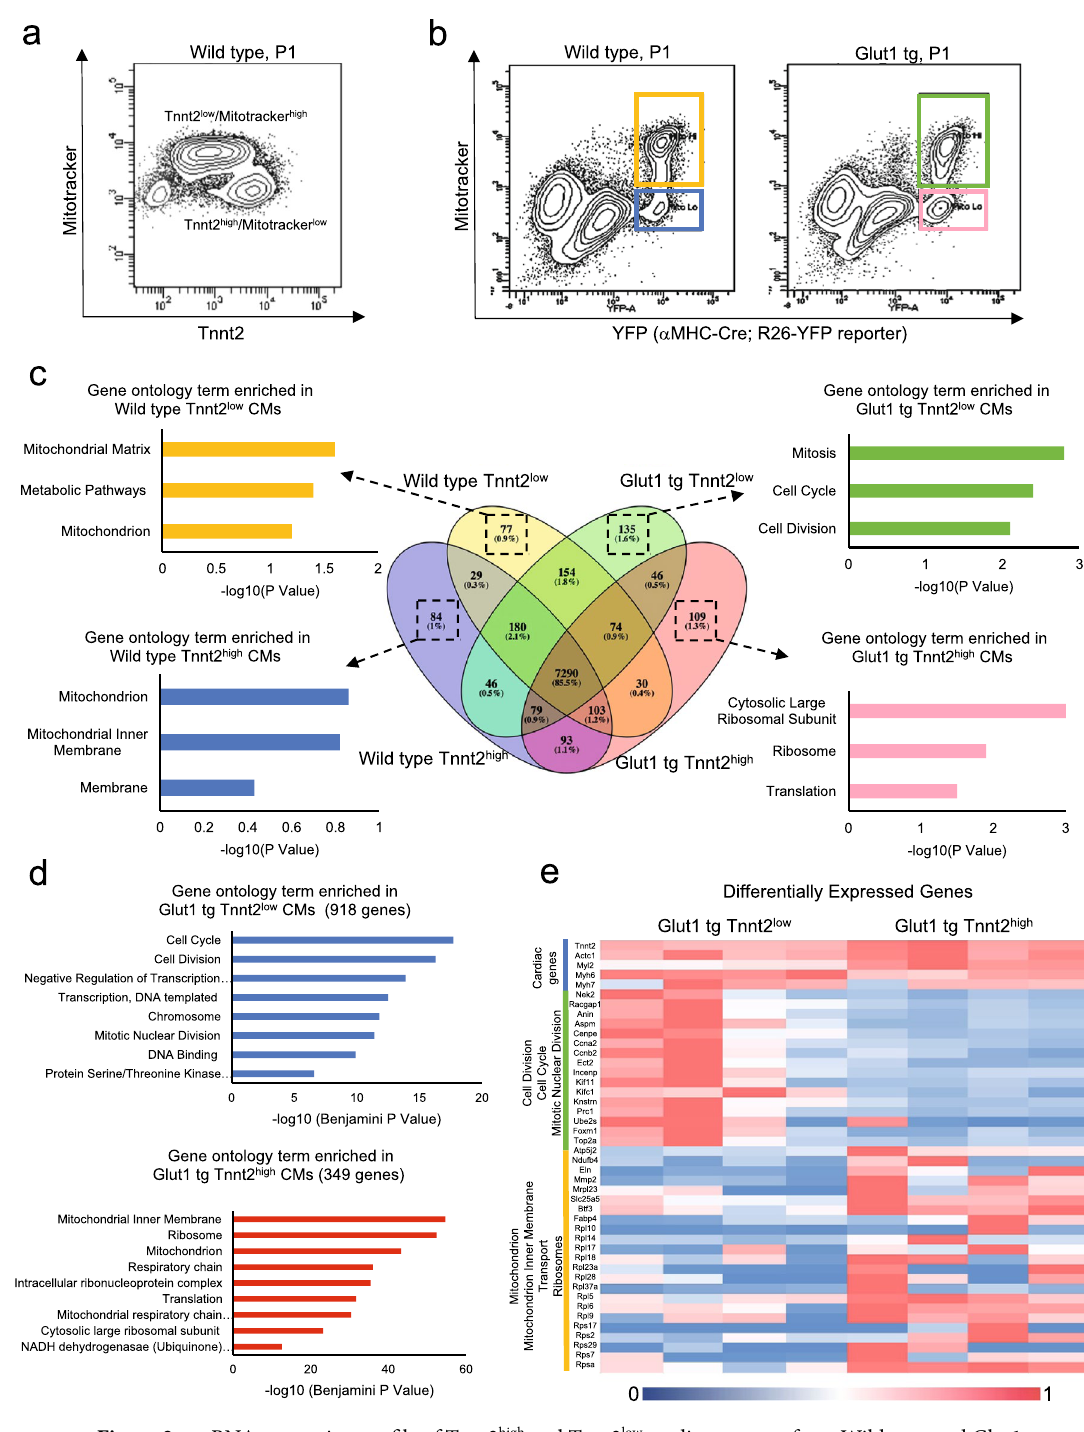
Figure 2. mRNA expression profile of Tnnt2 high and Tnnt2 low cardiomyocytes from Wild type and Glut1 transgenic hearts at P1. ( a ) Representative dot plot of flow cytometry analysis of P1 Wild type hearts for Tnnt2 (cardiac marker) and Mitotracker (mitochondrial contents). Note two populations of cardiomyocytes. ( b ) Flow cytometry analysis of P1 aMHC-Cre tg ; R26 + /YFP reporter and aMHC-hGLUT1 tg ; aMHC-Cre tg ; R26 + /YFP reporter analysis for YFP (cardiac lineage) and Mitotracker (mitochondrial contents). Note two populations of cardiomyocytes. ( c ) Venn diagram of mRNA expressed in Tnnt2 high and Tnnt2 low cardiomyocytes from Wild type and Glut1 transgenic hearts. Bar graphs represent top three gene ontology (GO) term enriched in the genes uniquely expressed in each population. Although 4 populations are similar, G1 Tnnt2 low cardiomyocytes are enriched for the genes associated with mitosis, cell cycle, and cell division. ( d ) GO analysis of the genes upregulated in Glut1 tg Tnnt2 low vs Glut1 tg Tnnt2 high . ( e ) Heatmap of expression level of representative cardiac, cell cycle, and mitochondrial genes differentially expressed in Glut1 tg Tnnt2 low vs Glut1 tg Tnnt2 high